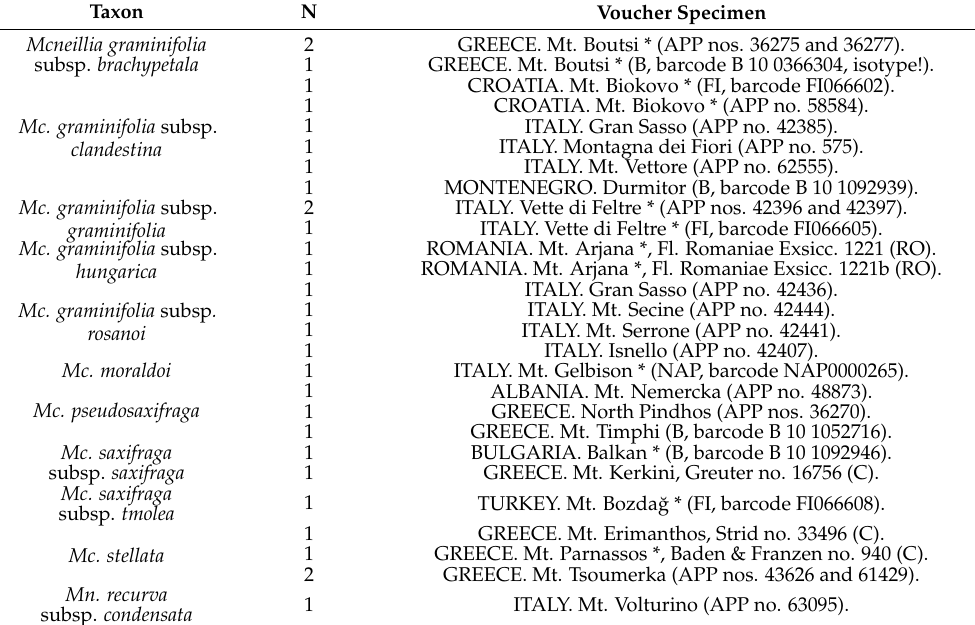
Table 2. Taxa examined in the study. N = number of individuals sampled. * = classic locality. Taxon